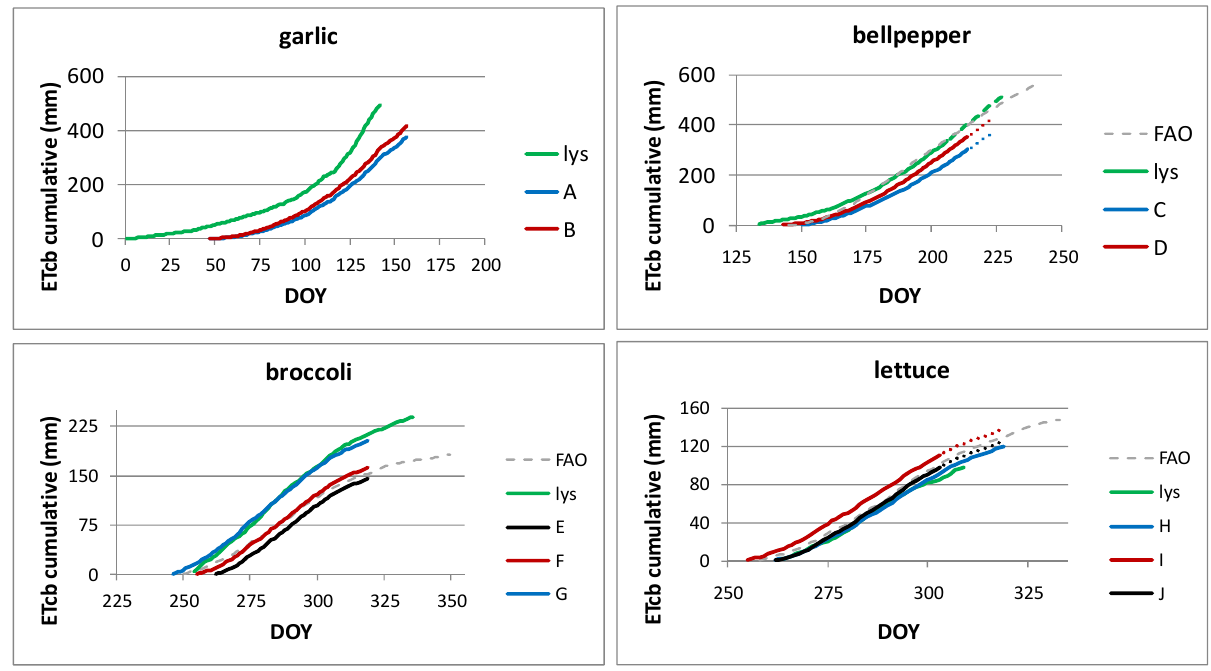
Figure 8. Cumulative basal evapotranspriation (ETcb) for four different crops, excluding initial stage, developed by lysimeter equations (Table 3) constrained by satellite-based Fc, and combined with CIMIS reference evapotranspiration. Letters represent fields of Table 2. Dotted portions of bellpepper (C,D) and lettuce (I,J) lines represent harvest period. Garlic profiles terminate at irrigation cutoff. Lysimeter [15] and FAO profiles are provided for reference as available. Dashed portion of the lysimeter line for bellpepper represents reported harvest period. Satellite-based profiles for fields E, F, G, and H are incomplete due to cloud